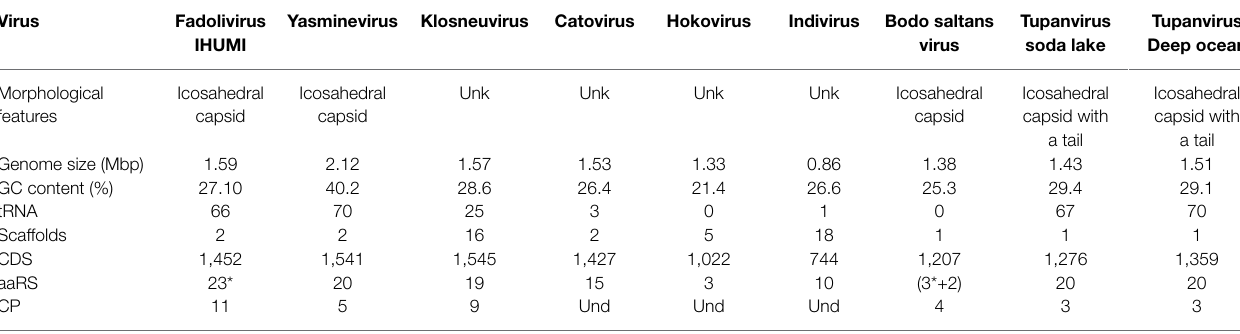
TABLE 1 | Morphological and genome characteristics of members of selected Klosneuvirinae and Tupanviruses.